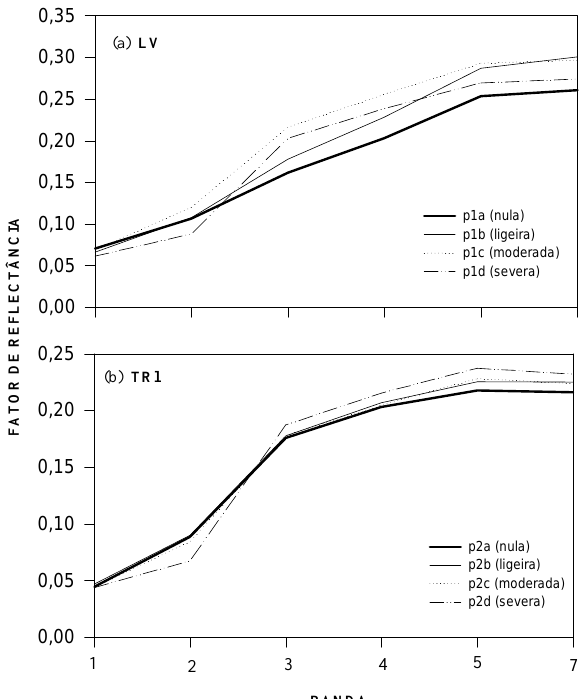
Figura 5. Dados espectrais simulados do TM-LANDSAT, do Latossolo Vermelho-Amarelo LV (a) e Terra Roxa Estruturada latossólica TRl (b) designados por diferentes níveis de erosão. Bandas: 1, 450-